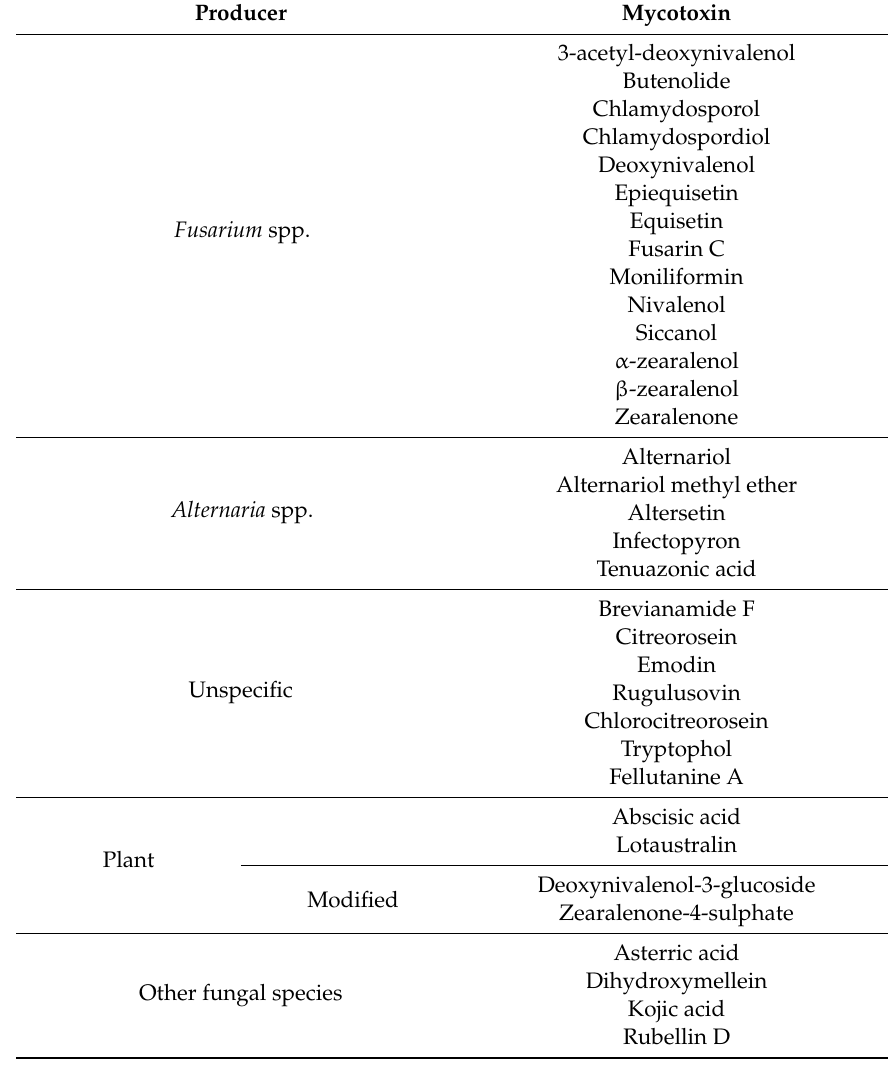
Table 6. General overview of detected toxins and their